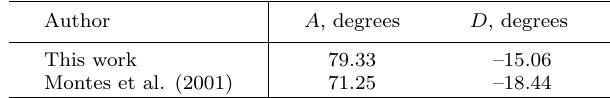
Table 1. Comparison of the Castor apex position